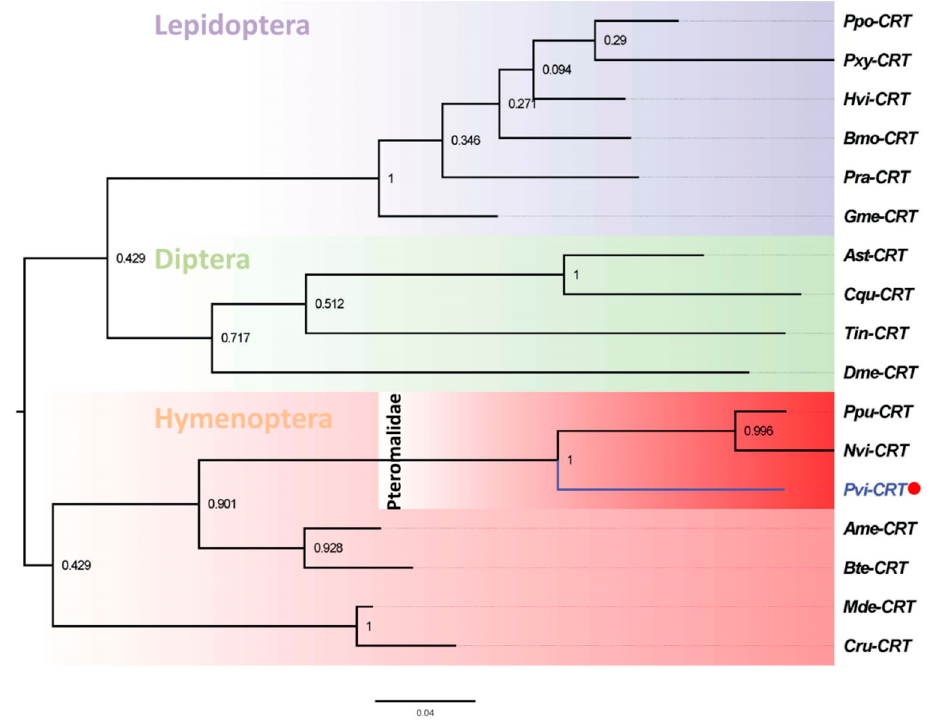
Figure 3. Phylogenetic tree of CRTs from P. vindemiae and other insects. The phylogenetic tree was constructed by the maximum likelihood method based on CRTs from P. vindemiae and another 17 insects using the program Mega 6 with 1000 bootstrap values. The GenBank accession numbers of 17 CRTs were listed as follows: Pvi ( P. vindemiae ); Dme (BAA85379.1, D. melanogaster ); Ast (AEM05956.1,